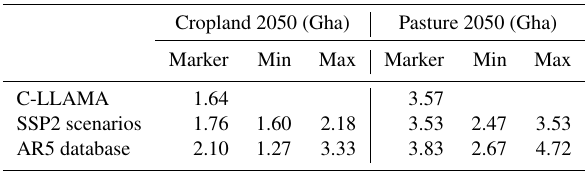
Table 2. Global cropland and pasture land cover in the year 2050 in C-LLAMA, SSP2 scenarios, and the AR5 scenario database. The mean of all AR5 scenarios is used for the AR5 database marker